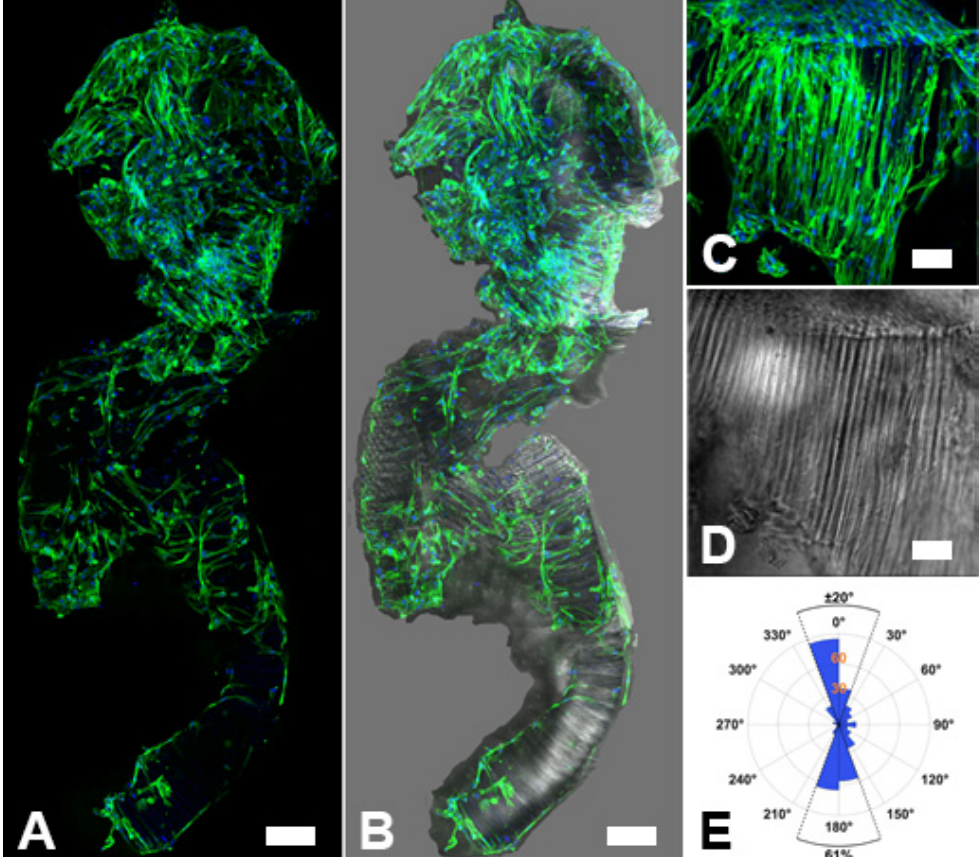
Figure 7. Human lung fibroblasts (HLFs) attach and spread on Capgel-PLL biomaterial ink extrusions in culture. ( A ) Large-area maximum z-projection confocal fluorescence mosaic micrograph composed of multiple contiguous image fields (10× mag) stitched together of HLFs colonizing a Capgel-PLL extrusion taken at one week in culture. ( B ) The same fluorescence micrograph as shown in ( A ) merged with the corresponding differential interference contrast (DIC) micrograph of the Capgel-PLL extrusion; ( C ) Maximum z-projection confocal fluorescence and ( D ) DIC micrographs of a microgel particle colonized by HLFs in another Capgel-PLL extrusion taken at one week in culture. ( E ) Polar plot of HLF nuclei orientations relative to the capillary long-axis from individual microgel particles in extruded Capgel-PLL like that shown in ( C , D ) colonized with cells that attached and spread during a one-week culture. Green fluorescence is from actin filaments stained with a conjugated phalloidin dye (Actingreen488) and blue fluorescence is from HLF nuclei stained with NucBlue. Scale bar = 200 µ m for ( A , B ) and 100 µ m for ( C , D